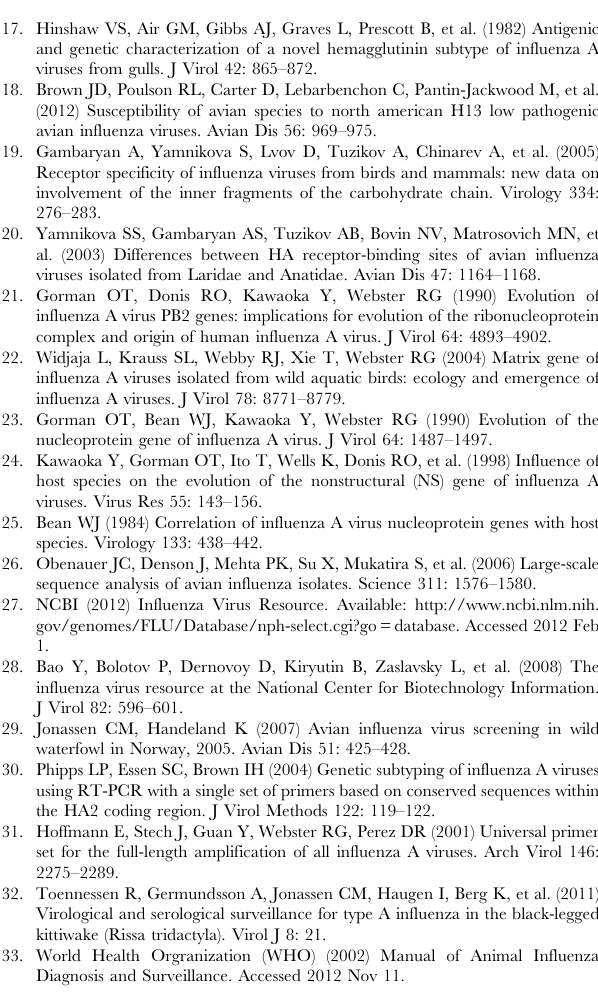
avian (non H13 and H16) and Eurasian gull (H13 and H16) avian influenza viruses (AIVs) included in the initial analysis. Table S1 Primers used in the PCR amplification of PB1 Table S2 Primers used for internal sequencing of the PA, PB1 and PB2 genes. Table S3 Accession numbers for complete AIV genomes from gulls in Eurasia, available from the Influenza Virus Resource at NCBI as of February